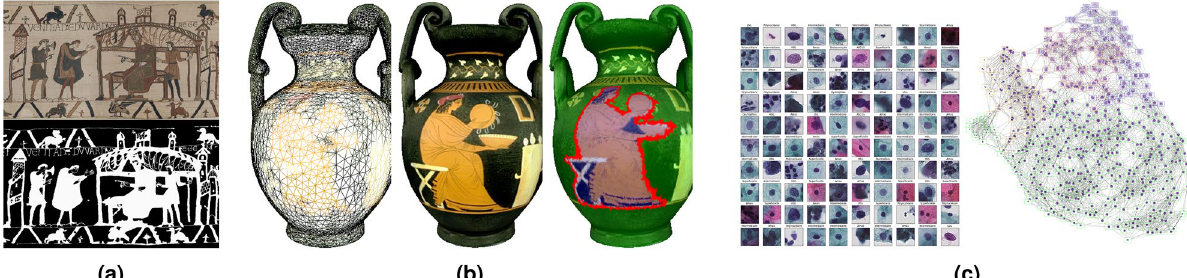
Figure 1. Examples of N-dimensional graphs, and of data processing problems which can be applied to them. ( a ) A 2D grid graph representing a color image, and the 2D segmentation of this image; ( b ) a 3D triangular graph representing a colored point cloud, and the 3D segmentation of this point cloud; ( c ) a ND point could graph constructed from a database of cells, and the data clustering of this graph. All these problems can be tackled using the same unified mathematical framework described in the present